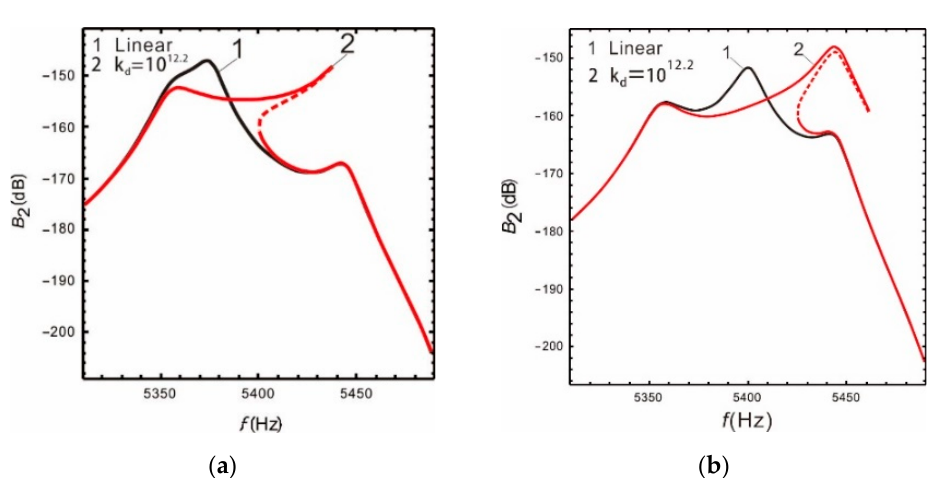
Figure 10. ( a ) (cid:2033) (cid:1876) = 5375 × 2(cid:2024) rad/s , ∆ = 90 Hz ; ( b ) (cid:2033) (cid:1876) = 5400 × 2(cid:2024) rad/s , ∆ = 90 Hz .